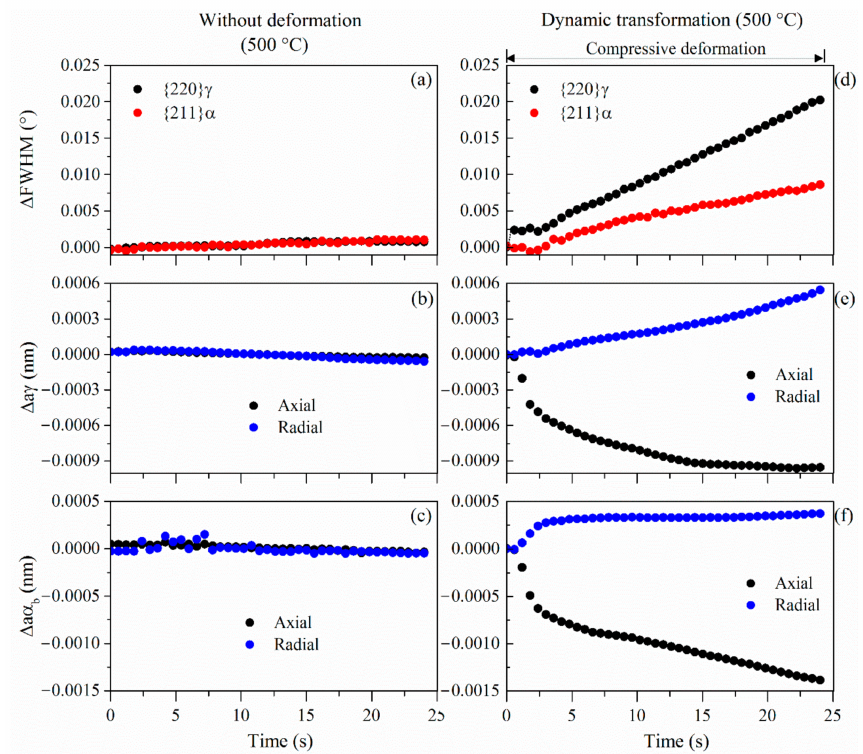
Figure 6. Evolution of the microstructural parameters at 500 ◦ C during bainitic transformation without compression (left diagrams) and during dynamic transformation (right diagrams)—( a , d ) FWHM of the {220} γ and {211} α diffraction peaks; ( b , e ) austenite lattice parameter; ( c , f ) bainitic ferrite lattice parameter. Note that all datasets are displayed as “ ∆ ” from the starting point t = 0 s, which is counted after the intermediate holding step (see the inset of Figure